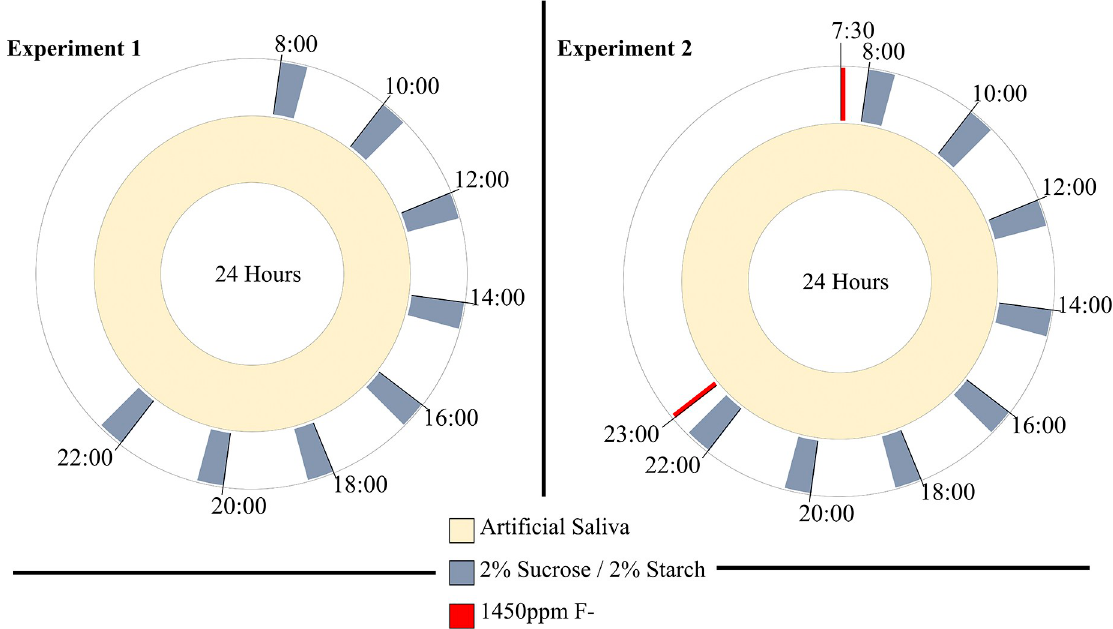
Fig 2. Pulsing strategy used throughout the experiments. Artificial saliva was pumped continuously whereas 2% sucrose 2% starch were pumped for 30 minutes 8 times daily. All solutions were pumped at a rate of 0.38 ml.min -1 . Experiment 2 had additional 1450 ppm F- pulses for 2 minutes at 0.38 ml.min -1 before and after the daily sucrose